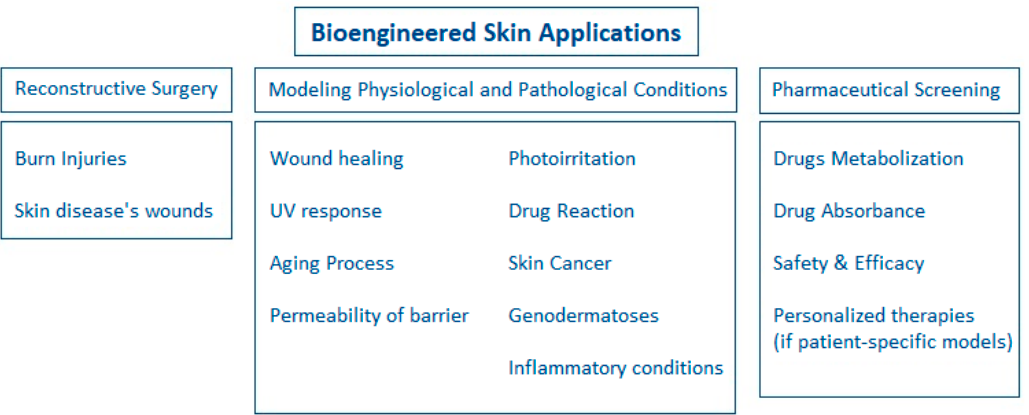
Figure 2. Diagram of the different applications of bioengineered skin: reconstructive surgery, modeling of physiological and pathological skin conditions, pharmaceutical screening.